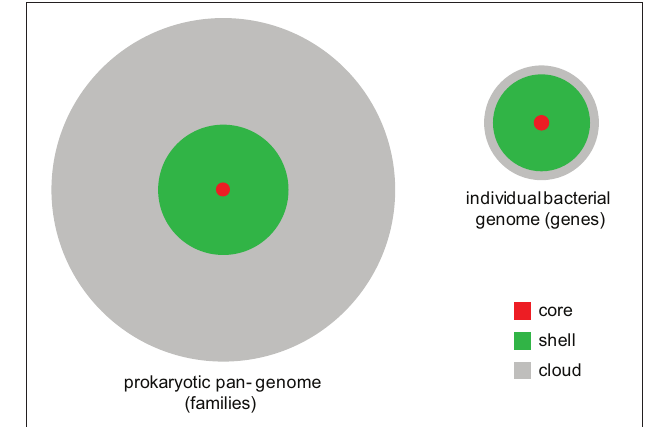
FIGURE 5 | The core, shell, and cloud of microbial genes. A generalized schematic showing the approximate contributions of the core, shell, and cloud to the pangenomesof prokaryotes and individual